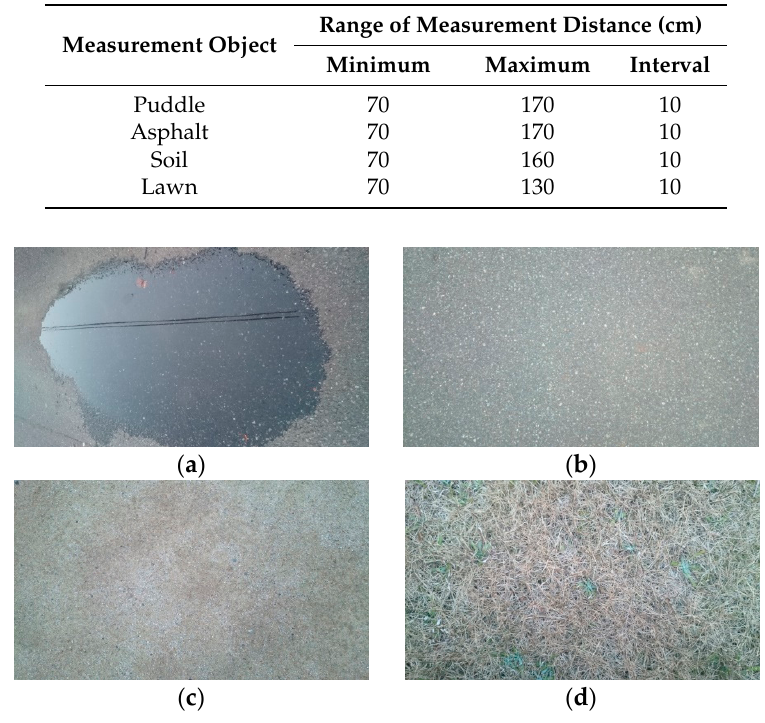
Figure 5. Measurement object: ( a ) Puddle; ( b ) Asphalt; ( c ) Soil; ( d ) Lawn.